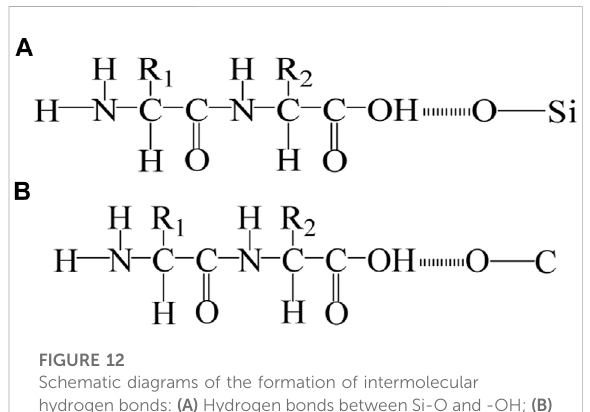
FIGURE 12 Schematic diagrams of the formation of intermolecular hydrogen bonds: (A) Hydrogen bonds between Si-O and -OH; (B) Hydrogen bonds between C-O and -OH.